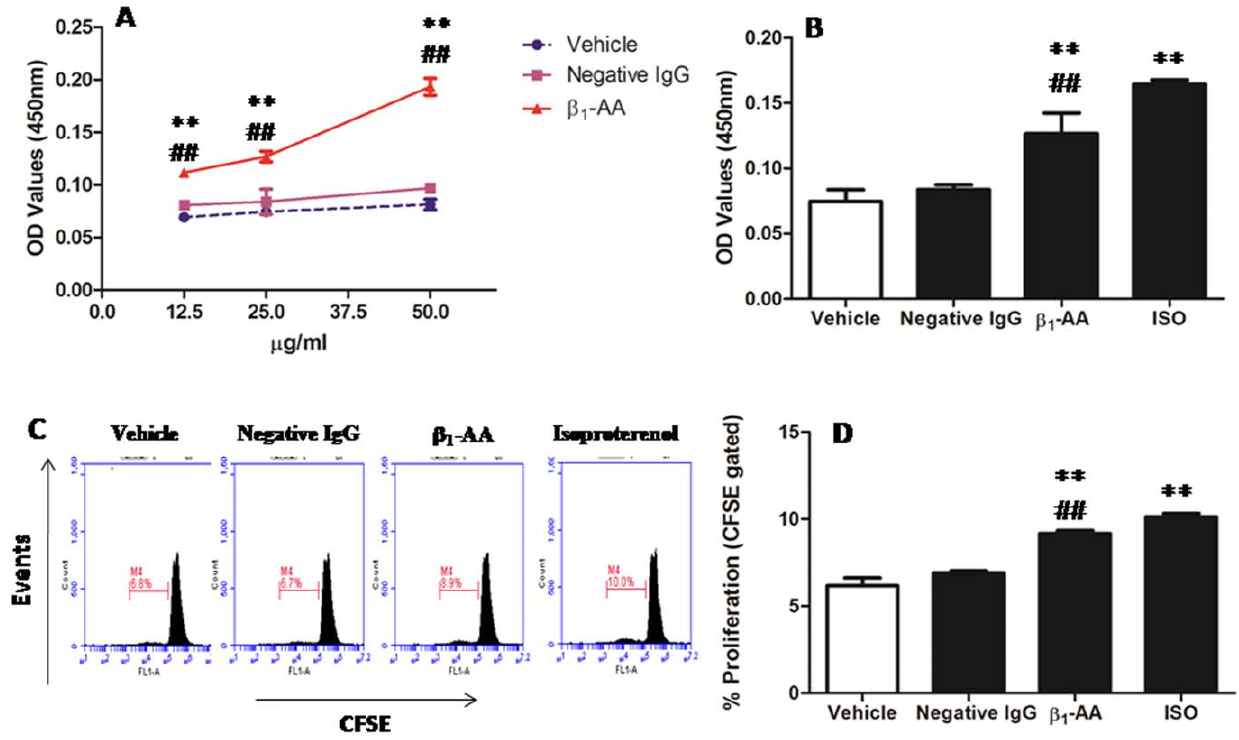
Figure 4. b 1 -AA from DCM patients significantly promoted the proliferation of CD3 + T cells. A. b 1 -AA promoted CD3 + T cell proliferation in a concentration-dependent manner. B. CD3 + T cells (5 6 10 5 cells/ml) were incubated for 48 h at 37 u C and 5% CO 2 in the presence of b 1 -AA (25 m g/ml) or isoproterenol (0.1 m mol/l). Cell proliferation was measured at 450 nm by CCK-8 uptake assay. ** p , 0.01 versus vehicle group; ## p , 0.01 versus negative IgG group. n =9 per group. C. CD3 + T cells were labeled with 4 m mol/l CFSE, and cell proliferation was measured by flow cytometry. Data shown here are representative of one of three different experiments with similar results. D. The bar graph shows the percentage of proliferating (CFSE lo ) T cells among the total CD3 + T cell population. n =3, * p , 0.05 versus vehicle group. ** p , 0.01 versus vehicle group; ## p , 0.01 versus Negative IgG group, ISO: isoproterenol.